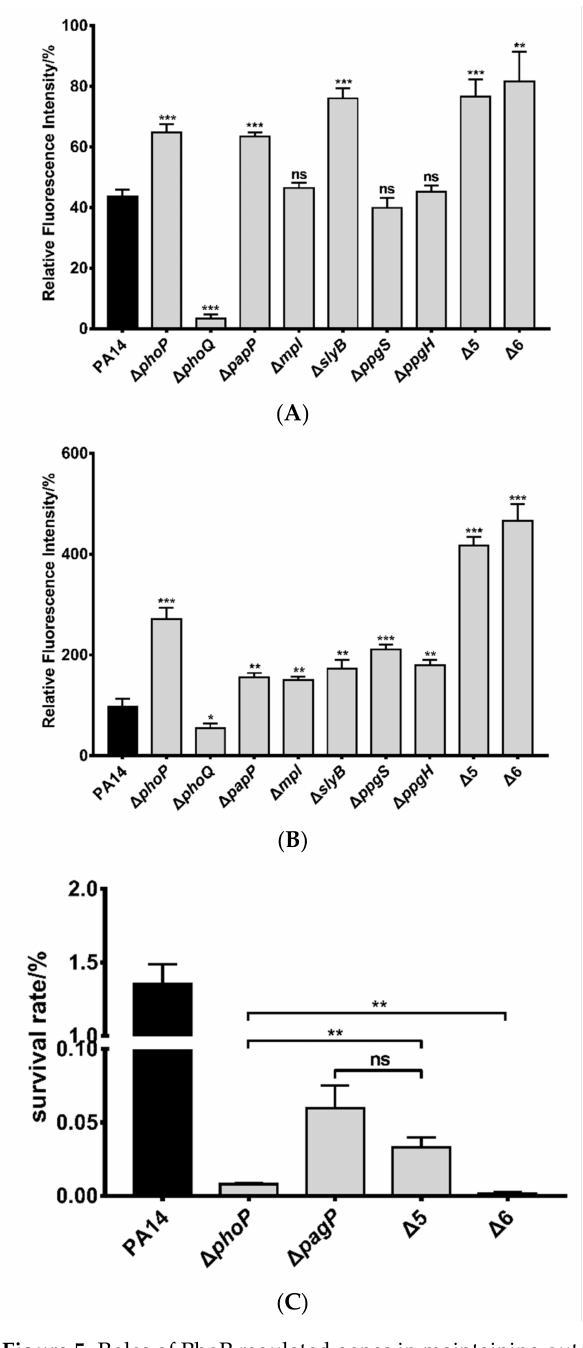
Figure 5. Roles of PhoP regulated genes in maintaining outer and inner membrane integrity. ( A ) Bac- teria at an OD 600 of 1.0 were collected and washed twice with 5 mM HEPES containing 5 mM glucose. The bacteria were resuspended in the HEPES buffer to an OD 600 of 0.5, followed by incubation with 10 µ M NPN at 25 ◦ C for 30 min. Then the bacteria were incubated with or without 0.78 µ g/mL polymyxin B at 37 ◦ C for 30 min, followed by fluorescence measurement. ( B ) Bacteria at an OD 600 of 1.0 were washed twice with PBS (pH 7.2) and resuspended in PBS to an OD 600 of 0.5. The bacteria were incubated with 10 µ M PI at 25 ◦ C for 30 min. Then the bacterial samples were incubated with or without 0.78 µ g/mL polymyxin B at 37 ◦ C for 1 h, followed by fluorescence measurement. ns, not significant. *, p < 0.05; **, p < 0.01; ***, p < 0.001 compared to PA14 by Student’s t -test ( C ) Wild-type PA14 and the indicated mutants were grown to an OD 600 of 1.0. The bacteria were treated with 0.78 µ g/mL polymyxin B for 2.5 h at 37 ◦ C. The live bacteria numbers were determined by serial dilution and plating. ns, not significant; **, p < 0.01, by Student’s t